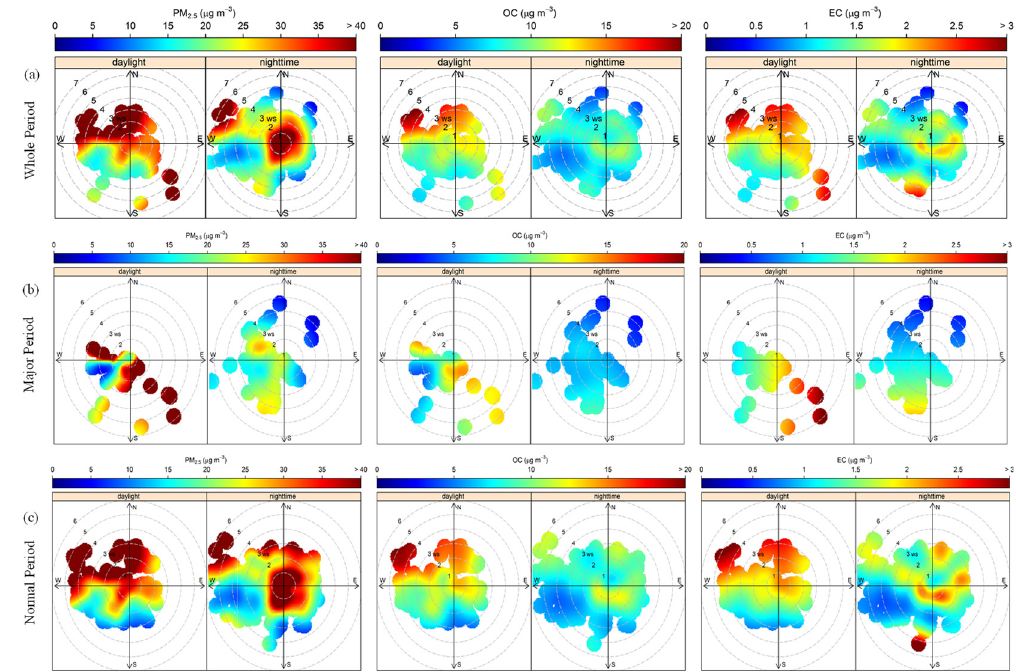
Figure 6. Relationship of PM 2.5 , OC, and EC concentration to wind direction and wind speed in Changchun by periods (i.e., ( a ) whole, ( b ) major, and ( c ) normal) and circadian rhythms (i.e., daylight vs. nighttime).